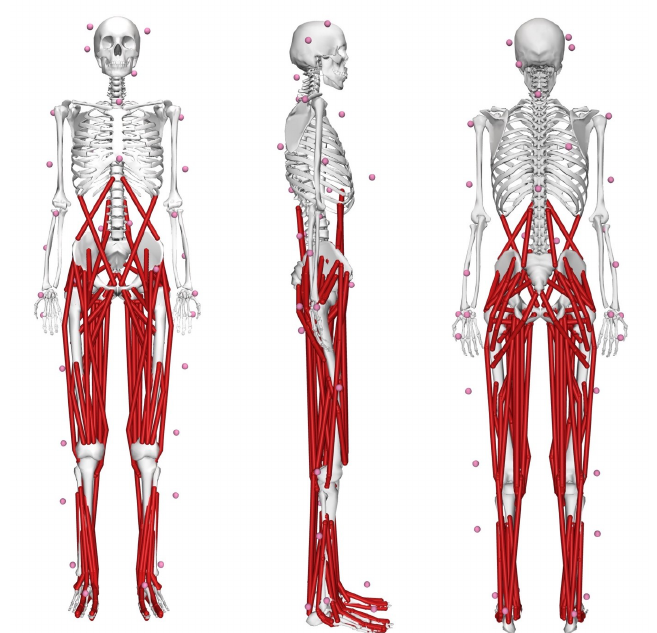
Figure 2. The anterior view, lateral view, and posterior view sides of the Rajagopal (2016) muscu- loskeletal model of OpenSim (Stanford University, Stanford, CA, USA, 4.3 version) consisting of surface markers, 37 degrees of freedom (20 DOFs in the lower body and 17 in the torso and upper body), 80 muscle–tendon actuators to actuate the lower limbs, and 17 torque actuators to simulate the